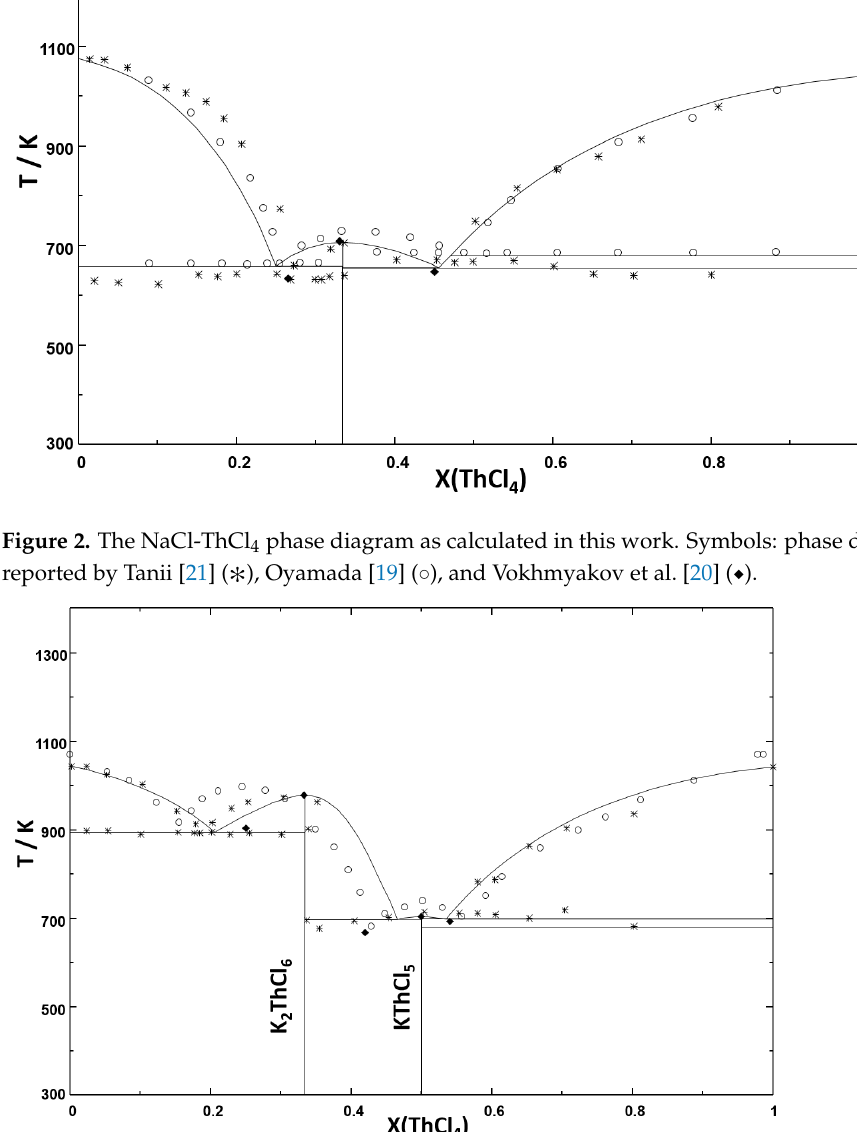
Figure 3. The KCl-ThCl 4 phase diagram as calculated in this work. Symbols: phase diagram data reported by Tanii [21] ( ˚ ), Oyamada [19] ( ˝ ), and Vokhmyakov et al. [20] ( ˛